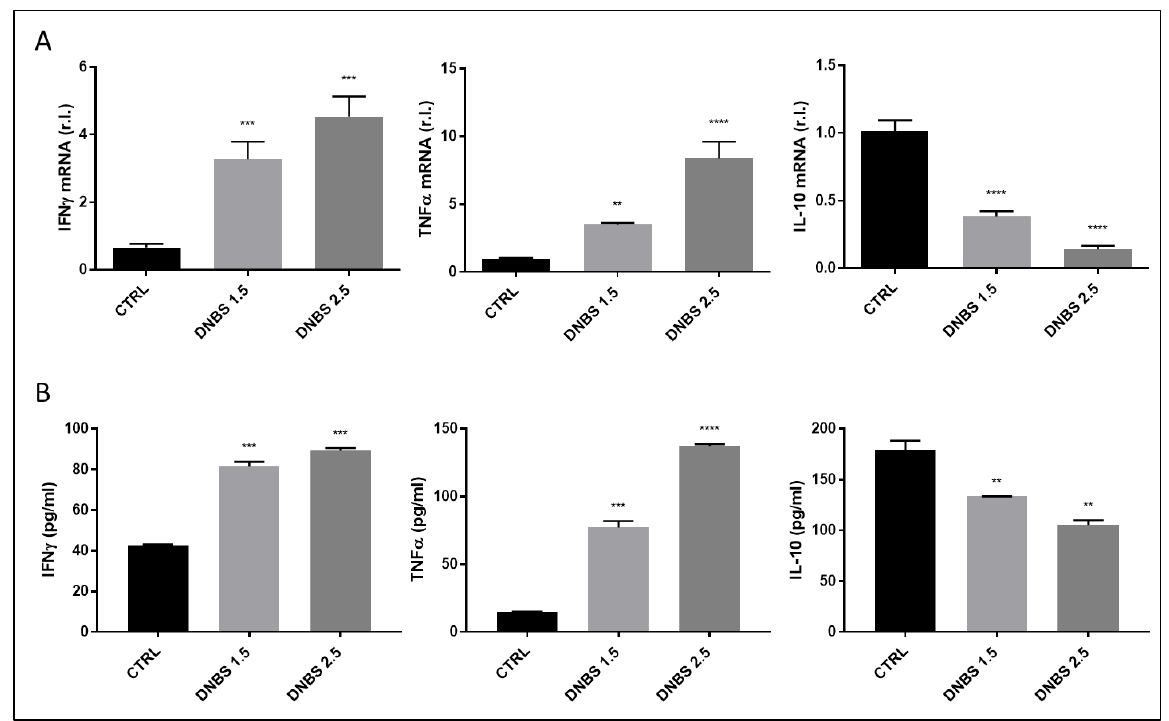
Figure 4. Inflammation induced by DNBS. Colon from C57BL/6 was cultivated for 5 h in a GEVS and untreated (CTRL) or treated with the indicated concentrations of DNBS and the expression levels of the pro-inflammatory cytokines IFNg and TNFa or the anti-inflammatory cytokine IL-10 were evaluated by both qPCR ( A ) and ELISA ( B ). Each panel is representative of experiments performed in triplicate. Histograms represent mean ± SD of triplicate sample; **** p < 0.0001; *** p < 0.001; ** p < 0.01.